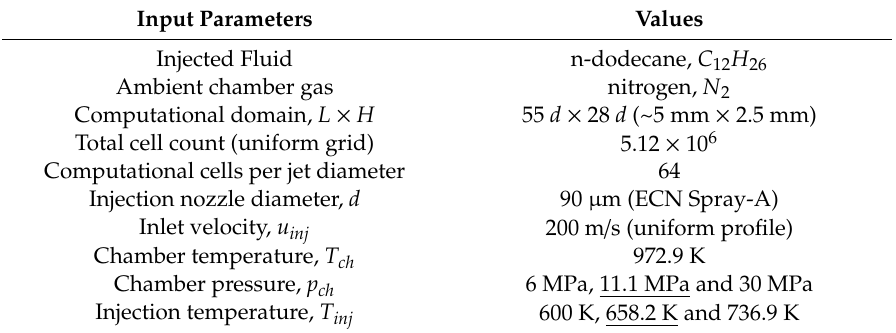
Table 3. Working parameters used in the case of non-cryogenic n-dodecane